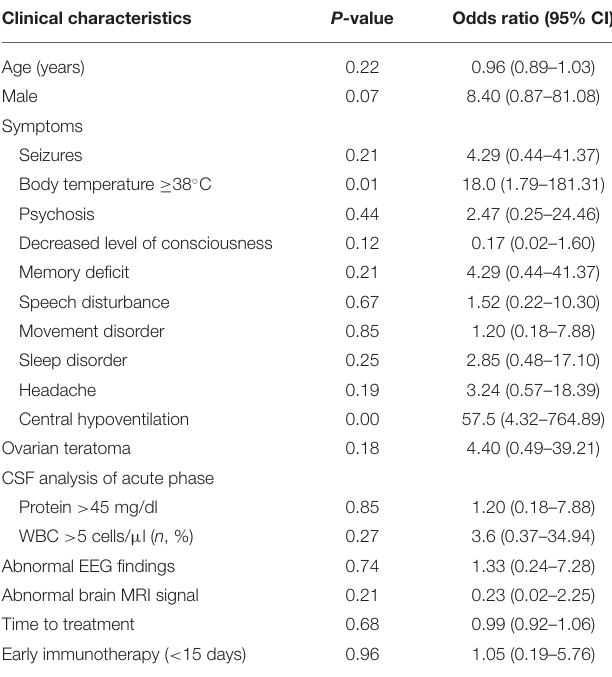
TABLE 1 | Clinical characteristics of patients with anti-NMDAR encephalitis. Clinical characteristics